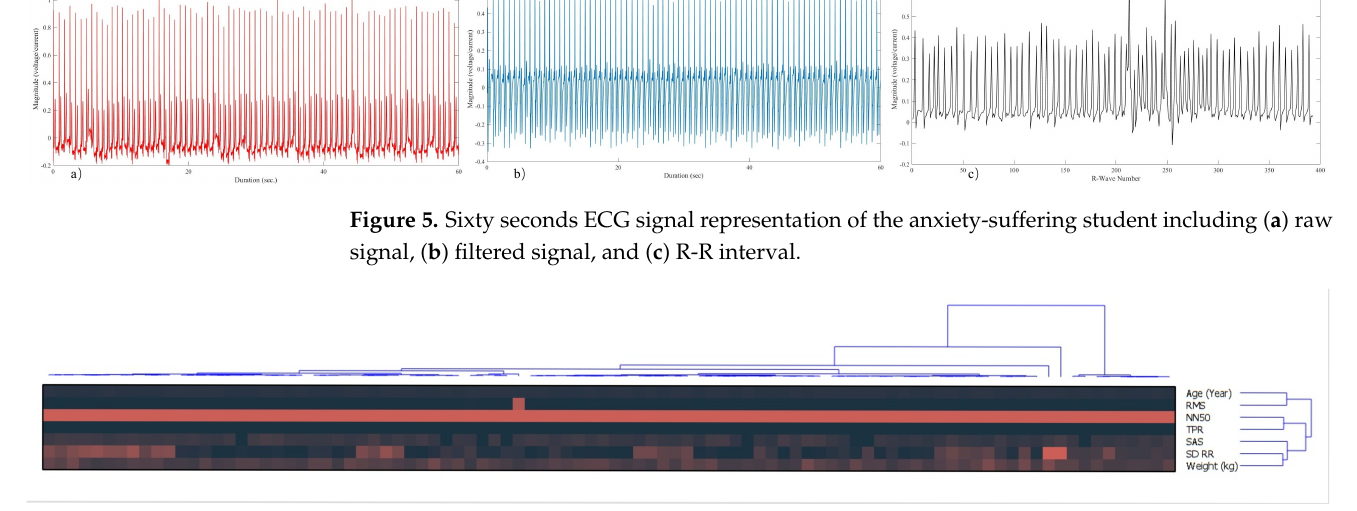
Figure 6. /hlHeat map based on mRMR-approved